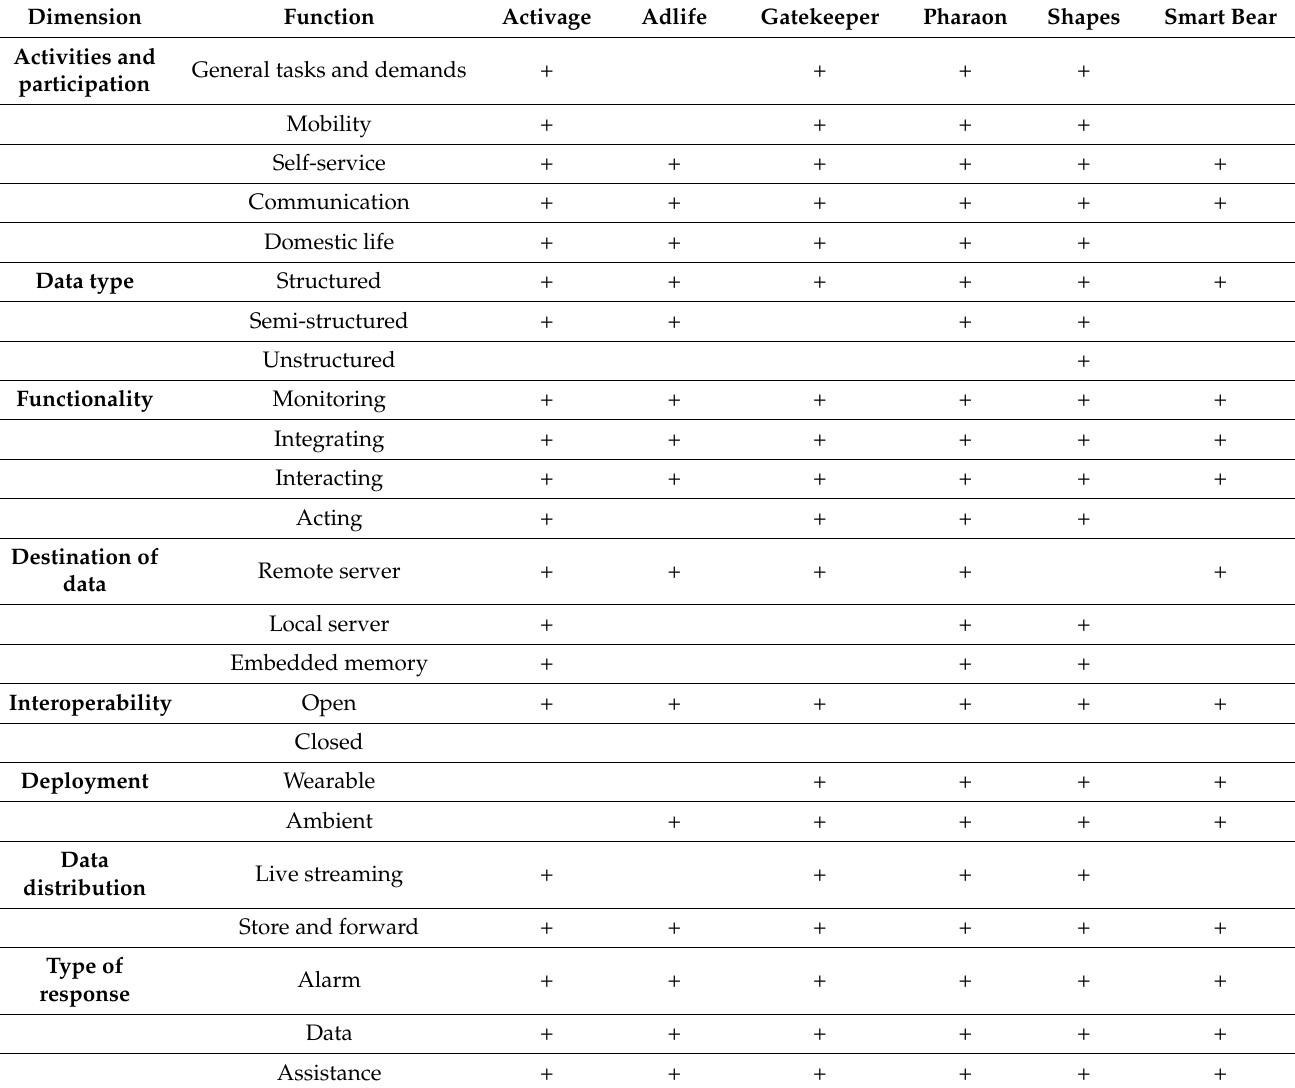
Table 3. Projects’ classification based on data quality-oriented AAL